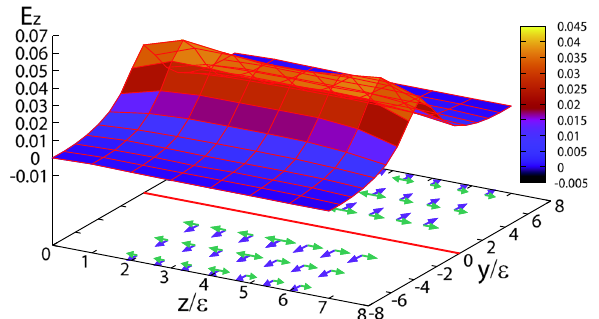
Fig. 12 The chromoelectric flux obtained in [17] and the distribution of the Maxwell stress forces F (ρ) and F ( z ) for the fitted value of the GL parameter κ = 0 . 565. We have taken the height of the cylinder as h = 8 (cid:4) to correspond to the distance between the static sources. The red line (the thick line in the y − z plane) stands for the ANO